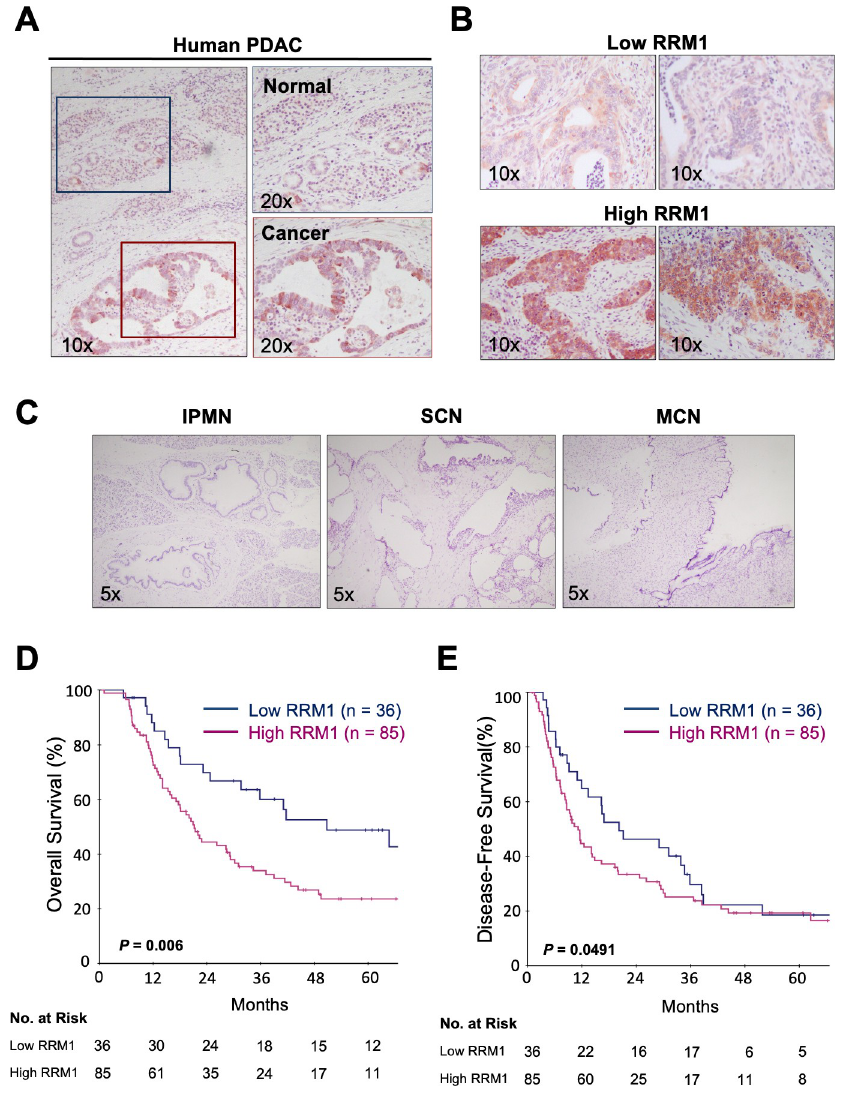
Fig 1. Association between RRM1 expression and prognosis in pancreatic cancer. (A) Left panel: representative immunohistochemical staining of pancreatic ductal adenocarcinomas with positive RRM1 expression. Right upper panel: adjacent normal pancreatic tissue. Right lower panel: ductal adenocarcinoma. (B) Representative immunohistochemical staining of low and high RRM1 expression levels. For the immunohistochemical staining of RRM1 in pancreatic cancer, the islets of Langerhans served as a positive internal control to evaluate the expression. RRM1 expression level was graded as low (no staining or weak intensity staining comparing to internal control in less than 30% of cells) or high (strong intensity staining in more than 30% of cells based on cytoplasmic staining intensity). The staining grade of RRM1 expression was assessed by two investigators and reviewed by one pathologist. ( C) Immunohistochemical staining of non-malignant pancreatic disease tissues. Left panel, intraductal papillary mucinous neoplasm (IPMN); middle panel, serous cyst neoplasm (SCN); right panel, mucinous cyst neoplasm (MCN). (D), (E) Kaplan-Meier curves for overall survival ( D ) and disease-free survival ( E ) of patients with pancreatic cancer with high or low RRM1 expression. RRM1 immunoreactivity in tumor cells was significantly associated with a worse prognosis (overall survival, P = 0.006, log-rank test; disease-free survival, P = 0.0491, Gehan-Breslow-Wilcoxon test). evidence [16,17,24]. However, biological importance of RRM1 expression on gemcitabine resistance remained still uncertain. Therefore, in vitro experiments were carried out to deter- mine the biological and functional effects of RRM1 expression on gemcitabine treatment.